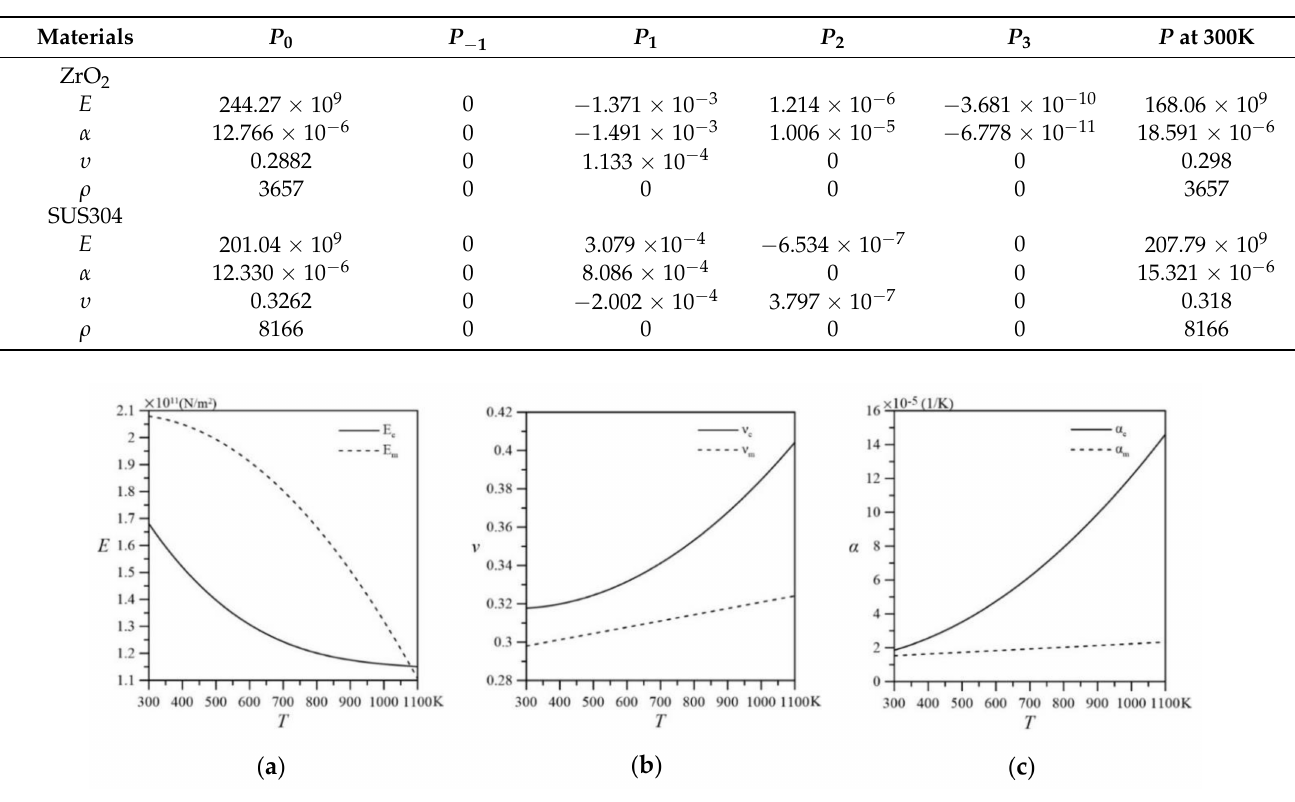
Table 4. Temperature dependent material properties of the metal material (SUS304) and the ceramic material (ZrO 2 ) [4]. Materials